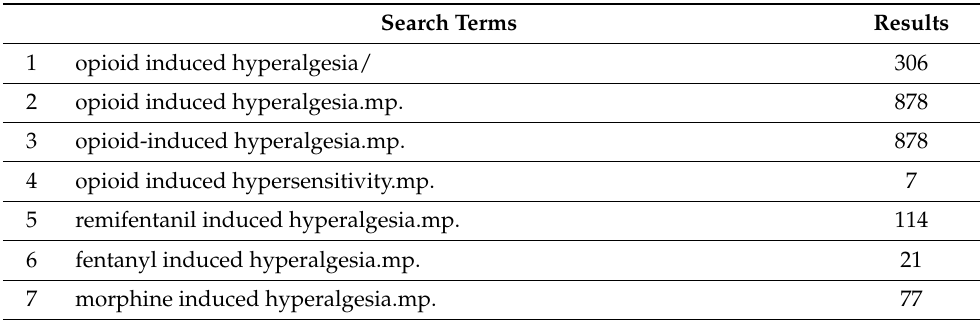
Table A2. Embase search strategy development (via Ovid). The number of records retrieved for search items in